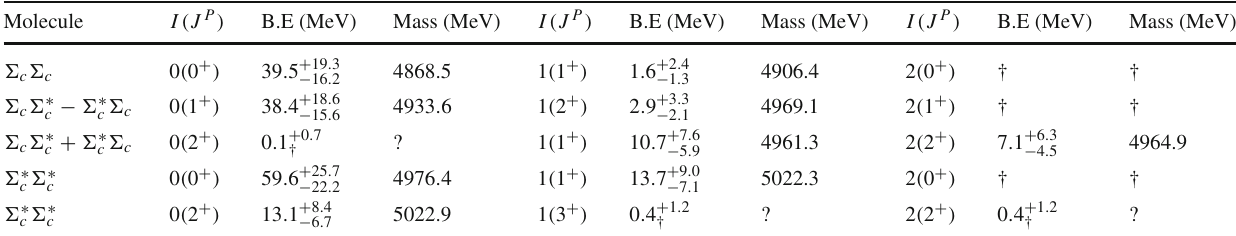
Table 2 Binding energies of (cid:2) ( ∗ ) c (cid:2) ( ∗ ) c molecules with the uncertainties originating from the breaking of HQSS and the corresponding masses, for which only central values are given. The † indicates that the particular system does not bind and ? denotes the likely existence of a bound state